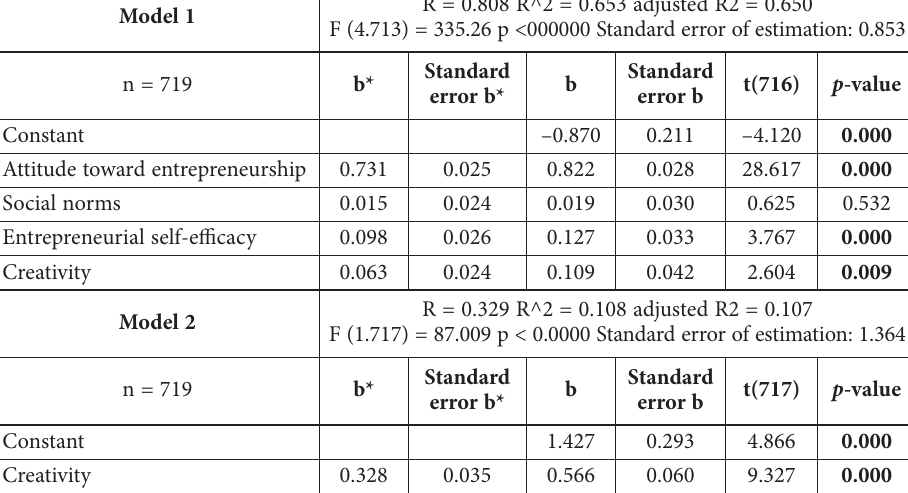
Table 1. Results of multiple regression for the dependent variable of “entrepreneurial intentions” among investigated students (source: created by authors) Model